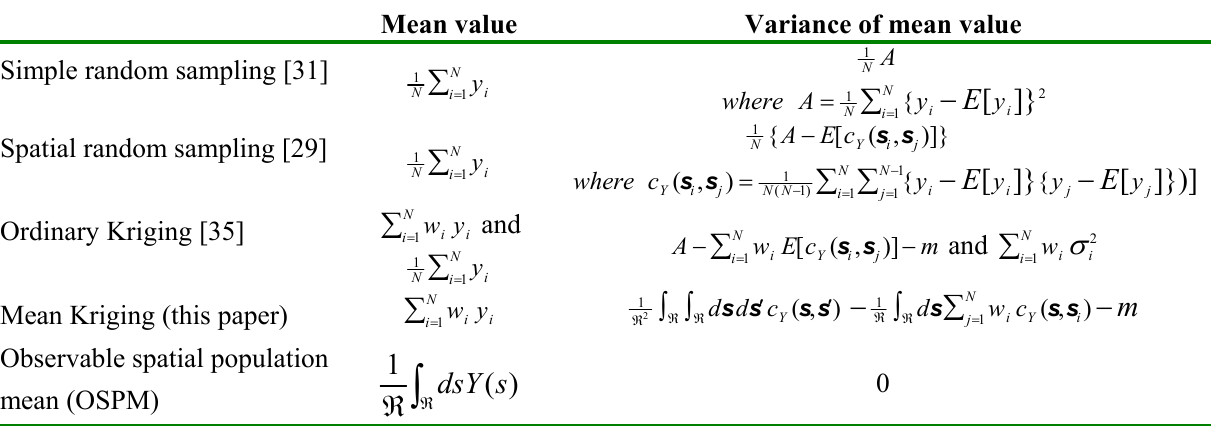
Table 4. Mean and variance formulas of four spatial estimation techniques. The OSPM is also shown. Mean